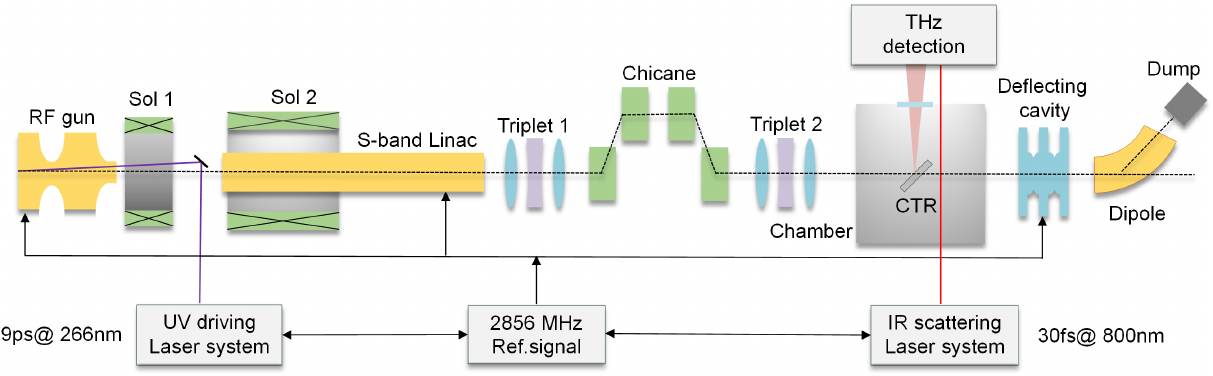
FIG. 2. Schematic layout of the beam line for